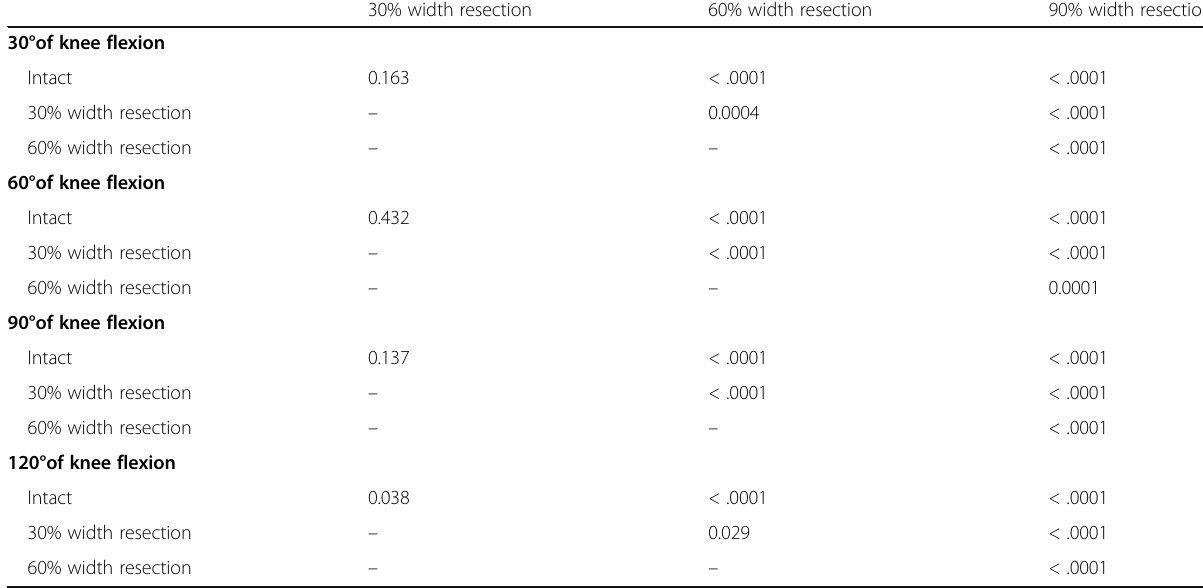
Table 2 All p-values of the statistical comparisons for in situ force of the medial meniscus between each meniscal